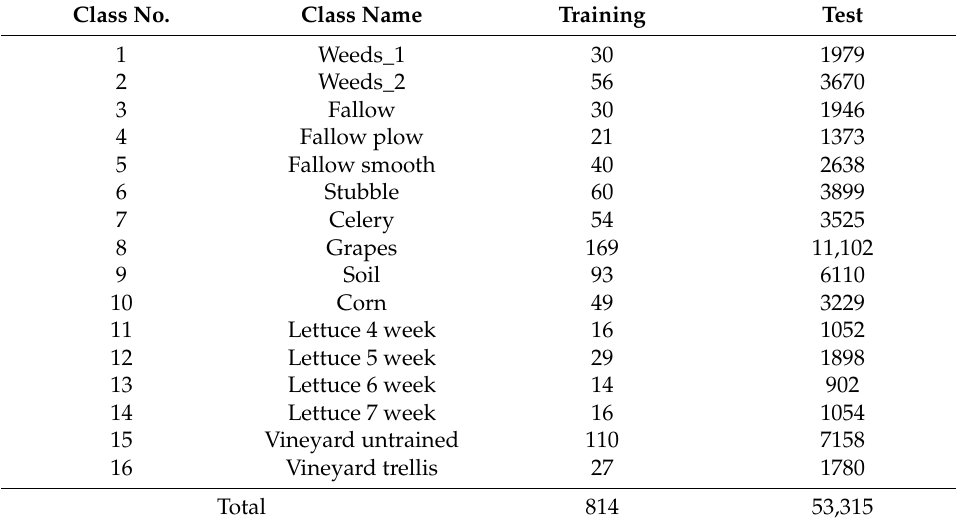
Table 5. Class Information for the Salinas image.